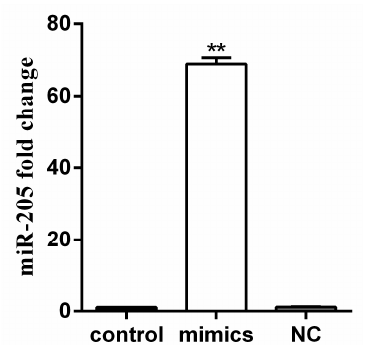
Figure 5. Fold change of miR-205 after miR-205 mimics transfection in HEK-293T at 24 h. miR-205 fold change levels were measured by Q-PCR. miR-205 expression values were normalized to housekeeping genes ( U6 ) expressed as a ratio of the control. Mean of the results from the control was set as 1. Data represent means ± SEM ( n = 3). ** p < 0.01, compared to control, independent-samples T -test.